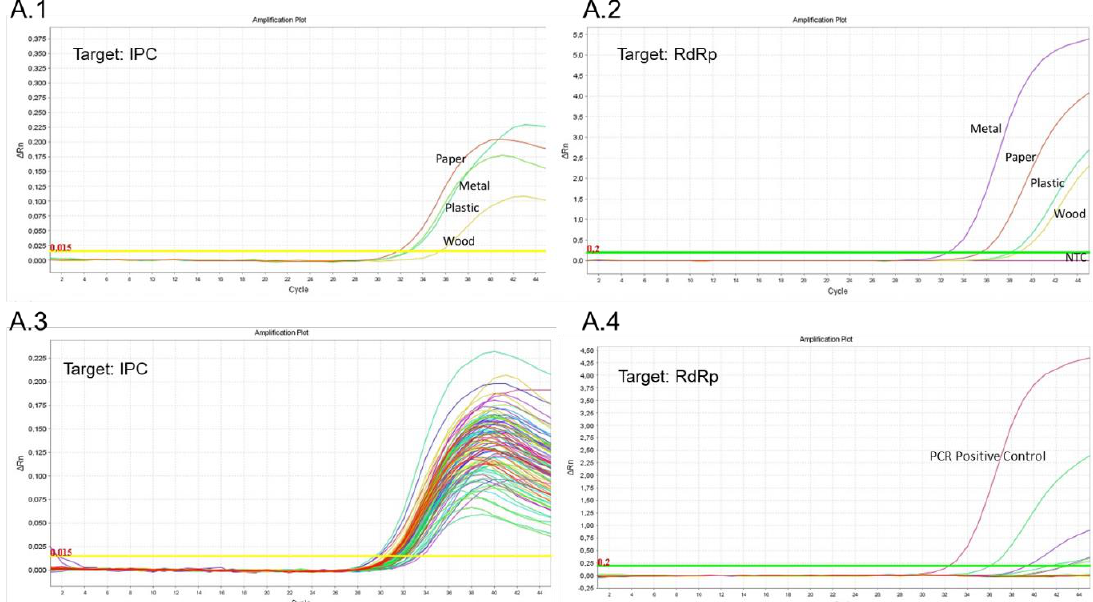
Figure A1. ( A.1 ) Amplification plot of Internal Process Control (IPC) and ( A.2 ) of RdRp gene of SARS-CoV-2 RNA in samples from 4 different artificially contaminated surfaces (plastic, metal, wood and paper); data from one representative experiment of 3 independent experiments are presented. ( A.3 ) Amplification plot of IPC and ( A.4 ) of RdRp gene of SARS-CoV-2 RNA in environment samples; in ( A.3 ) 94 samples are represented (all those that can be analysed simultaneously in a 96-well PCR plate); in ( A.4 ) 5 of the 9 positive samples found are represented (two plots